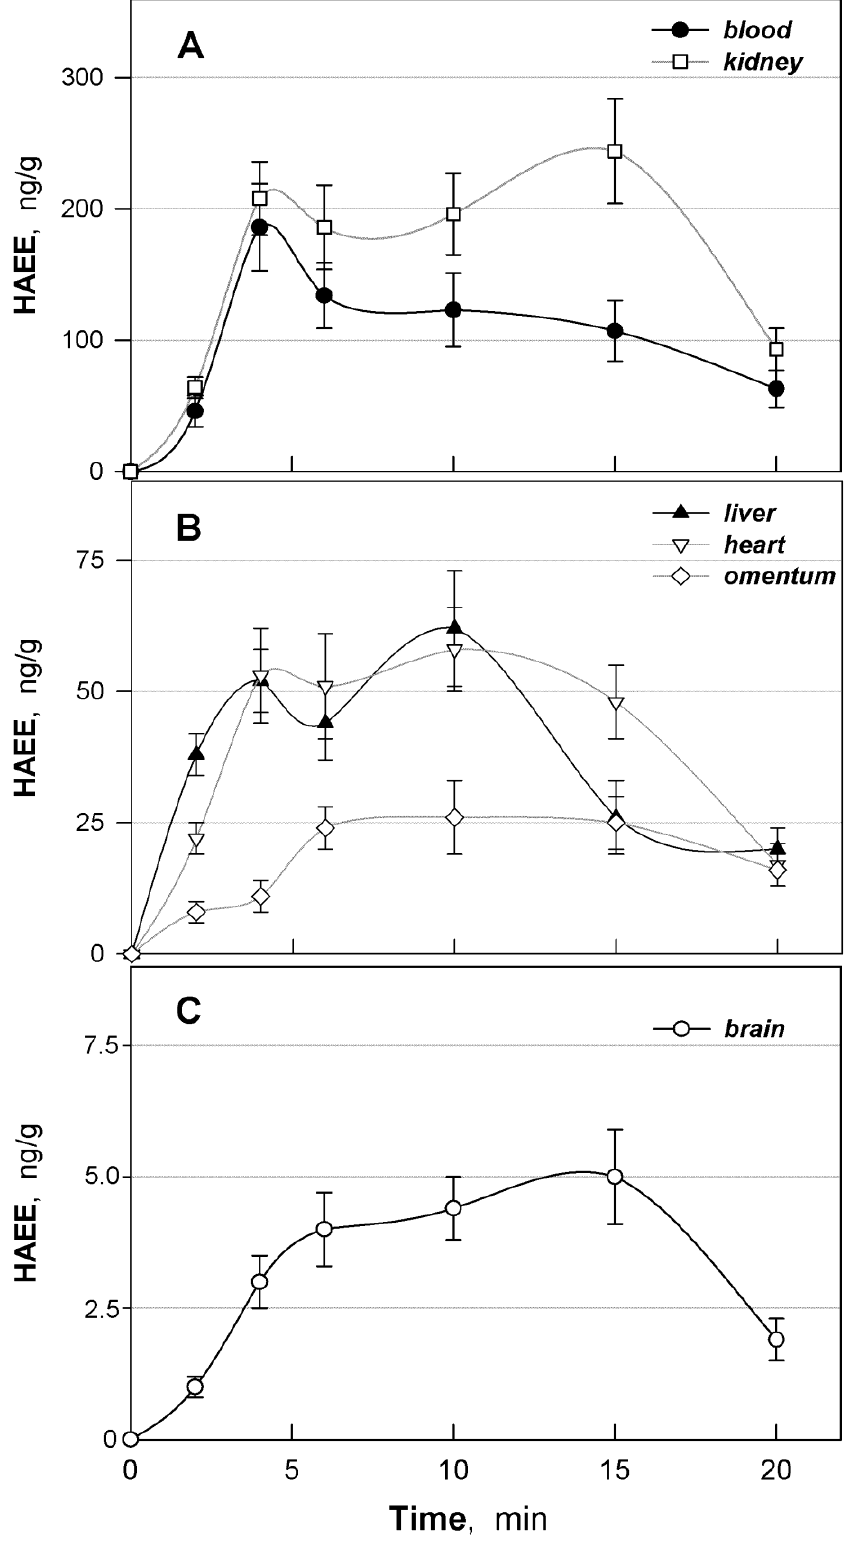
Figure 3. Distribution of HAEE between organs and tissues of mice after intraperitoneal bolus injection at a dose of 300 µ g/kg. ( A ). Quantity of HAEE in blood and kidneys; ( B ). quantity of HAEE in the liver, heart, and omentum; ( C ). quantity of HAEE in the brain.